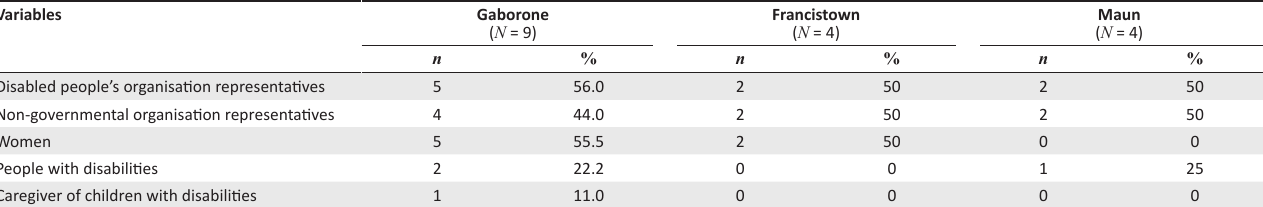
TABLE 1: Sampling for key informant